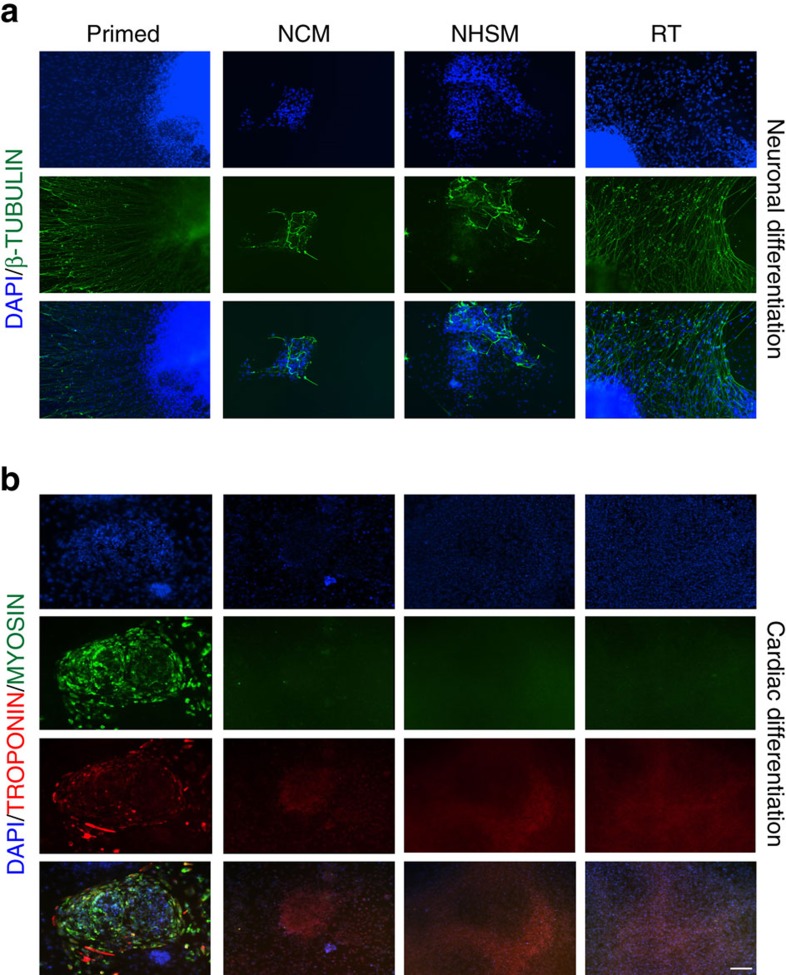
Directed differentiation of primed and naive hESCs towards neuronal and cardiac lineages.(a) Representative images of primed, NCM-, NHSM- and RT-MEF naive hESCs expressing β-TUBULIN when differentiated towards neuronal lineage. β-TUBULIN is expressed higher in neurons derived from primed and RT-MEF naive hESCs compared to NCM- and NHSM-MEF naive hESCs. (b) Representative images of primed, NCM-, NHSM- and RT-MEF naive hESCs expressing mature cardiac markers TROPONIN and MYOSIN when differentiated towards cardiomyocytes. Primed hESCs when differentiated towards cardiac lineage expressing markers TROPONIN and MYOSIN whereas all naive hESCs fail to express the mature markers. Scale bar, 200 μm.